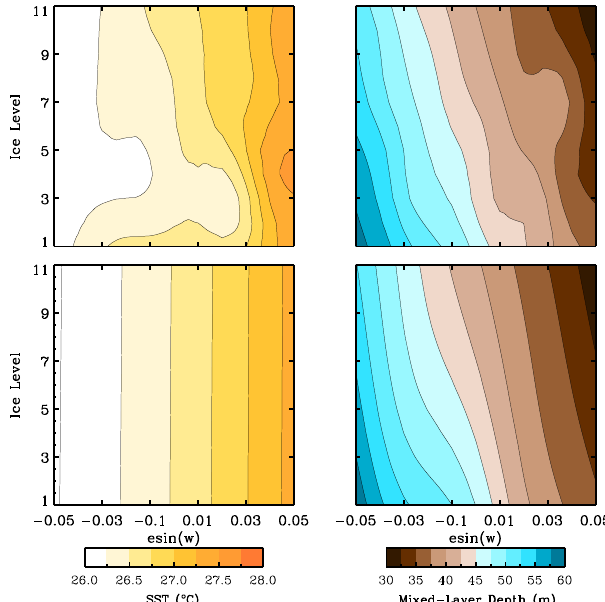
Figure 6. Sensitivity to glaciation level and e sin (cid:36) for sea-surface temperature and mixed-layer depth. Top panels: the contour plots include the experiments 11 and 40. The effect of these experiments are clearly visible in both cases, ice level 3 in the case of sea-surface temperature and glaciation level 7 for mixed-layer depth. Bottom panels: the removal of these experiments a smooth response of the emulator, as clearly seen in the contour plots.